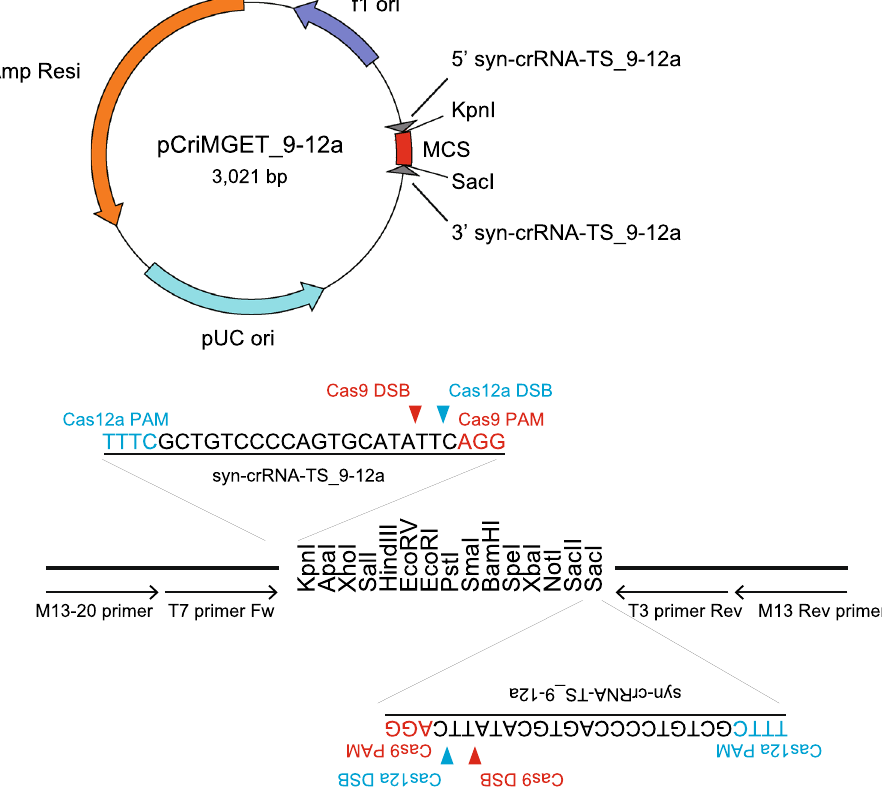
Figure 1. Development of the pCriMGET_9-12a plasmid. pCriMGET_9-12a harbors syn-crRNA-TS_9-12a at the 5 ′ and 3 ′ ends of the multiple cloning site (MCS). The Cas12a and Cas9 protospacer adjacent motif (PAM) sequences are shown in blue and red, respectively. The predicted double-strand break (DSB) sites induced by Cas12a and Cas9 within syn-crRNA-TS_9-12a are indicated by blue and red arrowheads, respectively. Black arrows show the locations of the M13-20, T7, T3, and M13 universal primers. Restriction enzyme ( Kpn I and Sca I) recognition sites within the MCS are